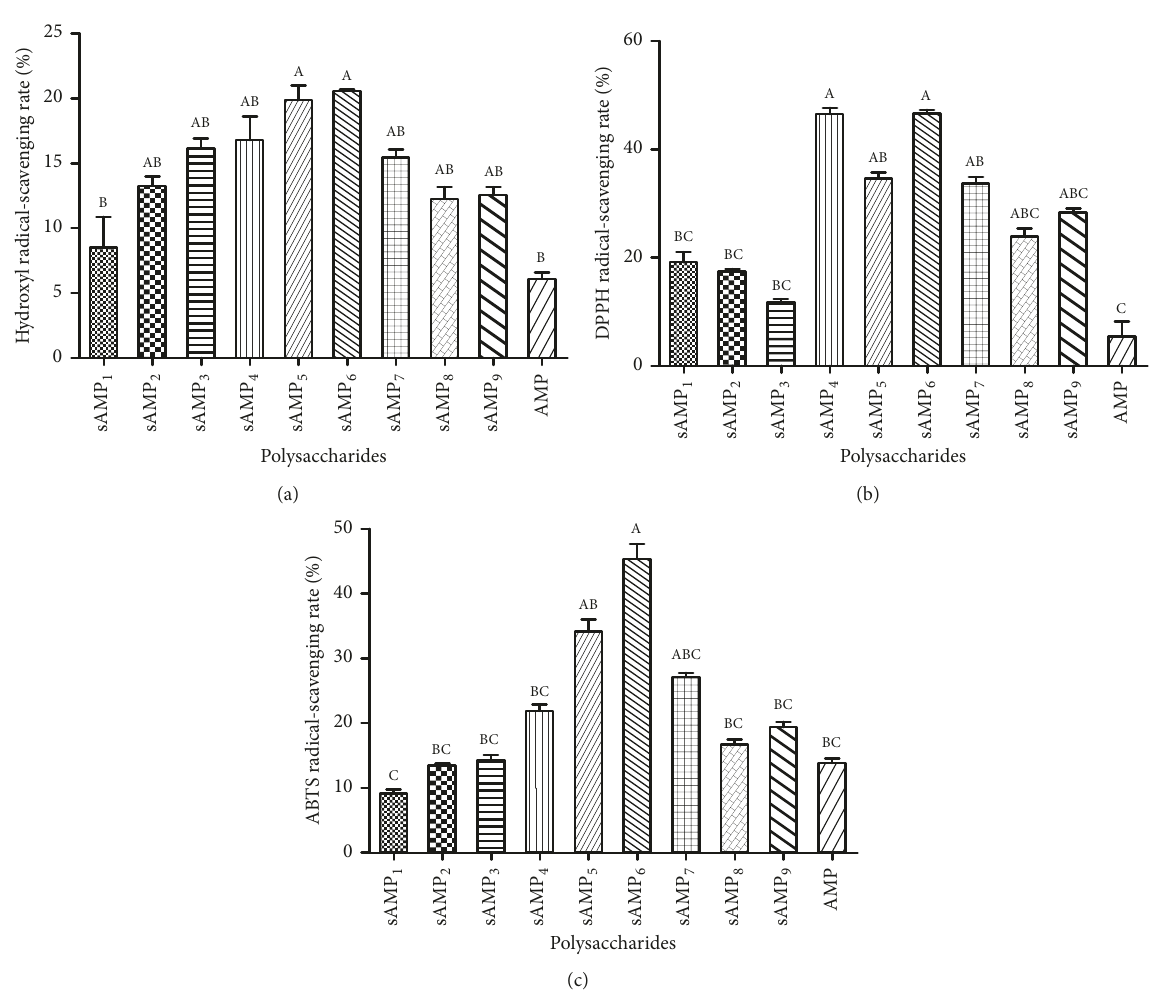
Hydroxyl radical is free radical having strong oxidizing power; it can make oxidation reaction of carbohydrates, proteins, nucleic acids, and other substances [21]. If it is not enough to remove the hydroxyl radical, it will trigger the body to produce many diseases. Salicylic acid detection method is currently the most widely used [22], the advantage of this method is that: it can simply simulate antioxidants scavenging hydroxyl radicals in tubes. The experimental results in vitro test showed that the hydroxyl radical-scavenging rates in all sAMPs groups were numerically or significantly higher than those in AMP group, in sAMP 6 were highest, and the next is sAMP 5 ; hydroxyl radical-scavenging rate of these two groups was significantly higher than that in AMP group. The results indicated that selenylation modification could significantly enhance the hydroxyl radical-scavenging activity of AMP, and action of sAMP 6 was the